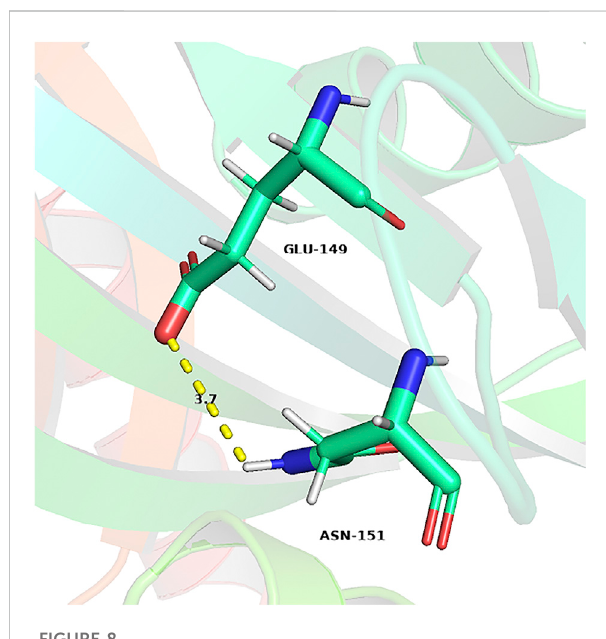
FIGURE 8 Hydrogen bonds formation between E149 and